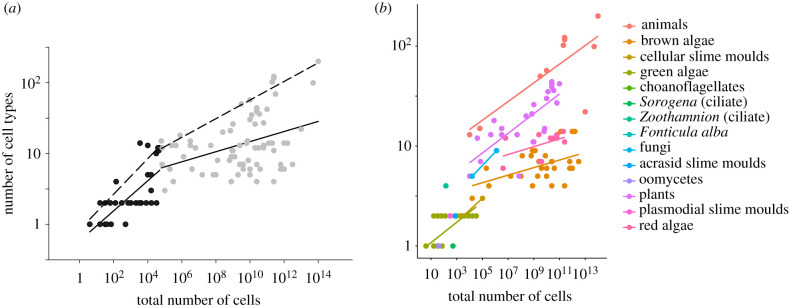
(a) Scaling across multicellular species. The relationship between number of cell types and total number of cells for smaller (in black) and larger multicellular species (in grey) shown on logarithmic axes. Small species (i.e. those below 6.3 × 104 cells) show a steeper allometry (OLS regression: slope = 0.21 (confidence interval = 0.16 – 0.26) compared to large species (i.e. those larger than 6.3 × 104 cells; OLS regression: slope = 0.07 (confidence interval = 0.03 – 0.11). Solid lines show the OLS regression and dashed lines show regressions through the upper 90% quantile of the data. We estimated the breakpoint of 4.8 ± 0.9 (corresponding to 6.3 × 104 total cells) using the ‘segmented’ package in R. (b) Multicellular organizational complexity across different multicellular lineages. Organizational complexity, measured as both the number of cell types and the total number of cells, for each of the independently evolved multicellular lineages. Original data from Fisher et al. [4]. The statistical results of the different regressions are given in the electronic supplementary material, table S1. N total = 126 species where we had data for both number of cell types and total number of cells.